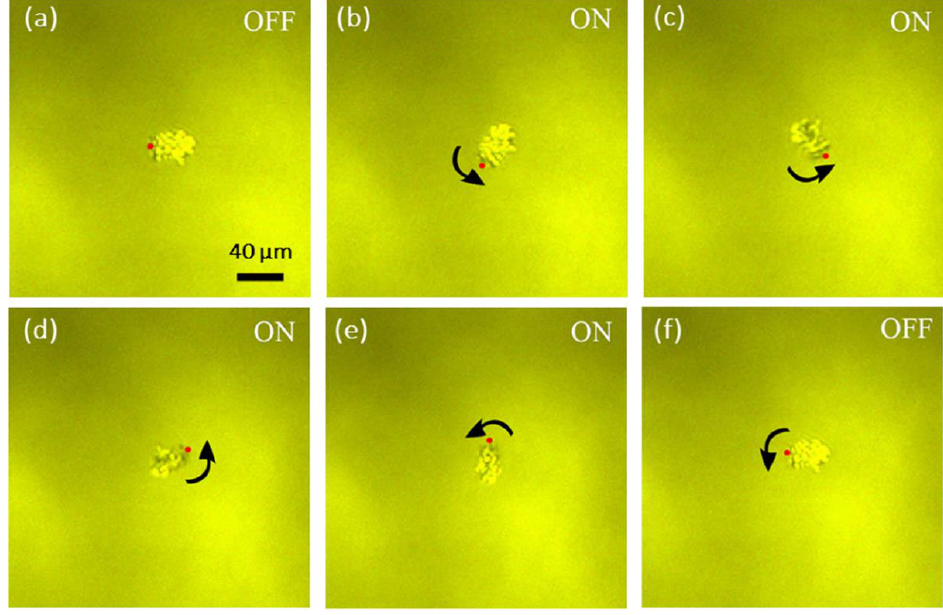
Micromachines 2021 , 12 , x FOR PEER REVIEW Figure 4. ( a – f ) Snap shots of rotating CsPbBr 3 microplates in every 1/6 s. Due to influencing factors such as dielectric strain and electrolyte shielding effect, to minimize contact with the substrate to reduce the deviation in characterizing 2D material becomes increasingly important. Herein, we have obtained the specific conductivity of the CsPbBr 3 microplates in a contactless manner. By processing the rotation of CsPbBr 3 mi- croplates through image processing, we can obtain the rotation speed of the CsPbBr 3 mi- croplates based on previously derived Equation (7). The conductivity of the CsPbBr 3 mi- croplates measured by this contactless manner ranges from 10 − 9 – 10 − 8 S/m. Moreover, as shown in Figure 5, the rotation speed of the CsPbBr 3 microplates decreases with increasing the frequency of the AC electric field. The aforementioned theoretical derivation can be used not only for contactless measurement, but also for precise manipulation of micro- plates under an external AC electric field. This manipulation principle provides a feasible way to precisely control the rotation of 2D micromotors.